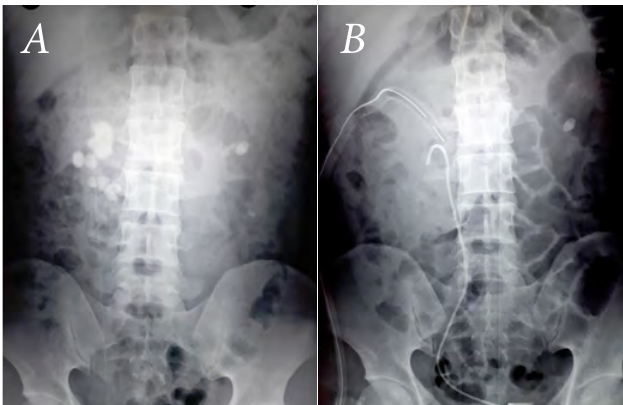
Fig 2: (A) X-ray Plain KUB showing stones in both horseshoe kidneys, (B) KUB of same patient after PCNL on right